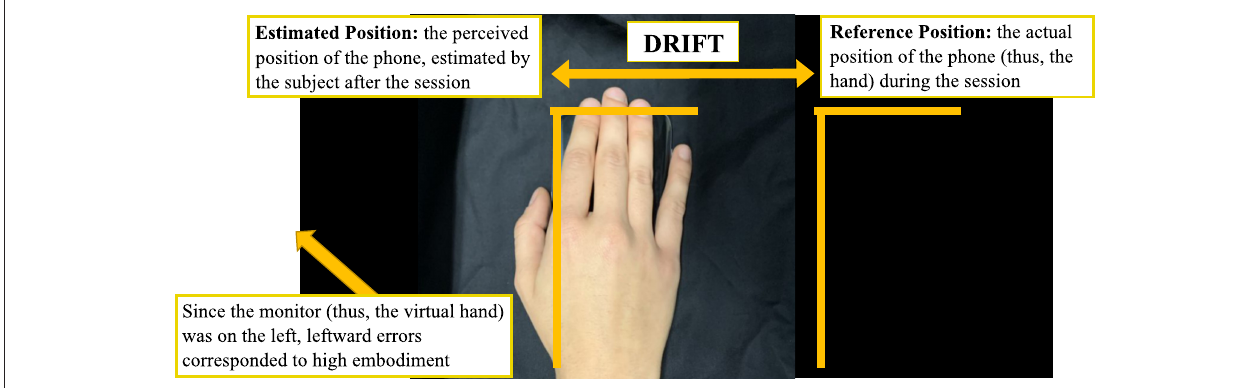
FIGURE 5 | Proprioceptive drift measurement—only the lateral error from the actual phone position (reference position) was considered.